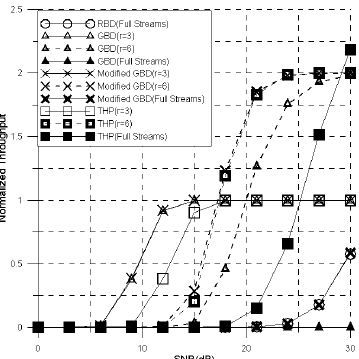
Figure 6. The throughput comparison when each of the 3 UEs has 3 receive antennas and the BS has 9 transmit